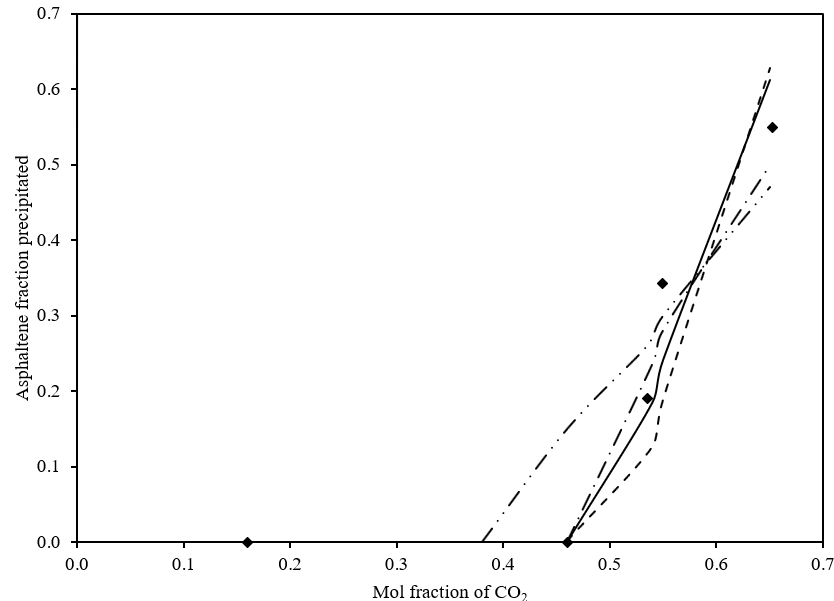
Figure 4. Effect of CO 2 injection (in Weyburn oil) on precipitated asphaltene fraction. Experimental data ( ◆ ), ( ━ ‥ ━ ) calculated by Wu et al., ( ━ ･ ━ ) calculated by Shirani et al., ( ━ ) calculated by Pan and Firoozabadi, and ( ━ ━ ) calculated by Li and Firoozabadi.